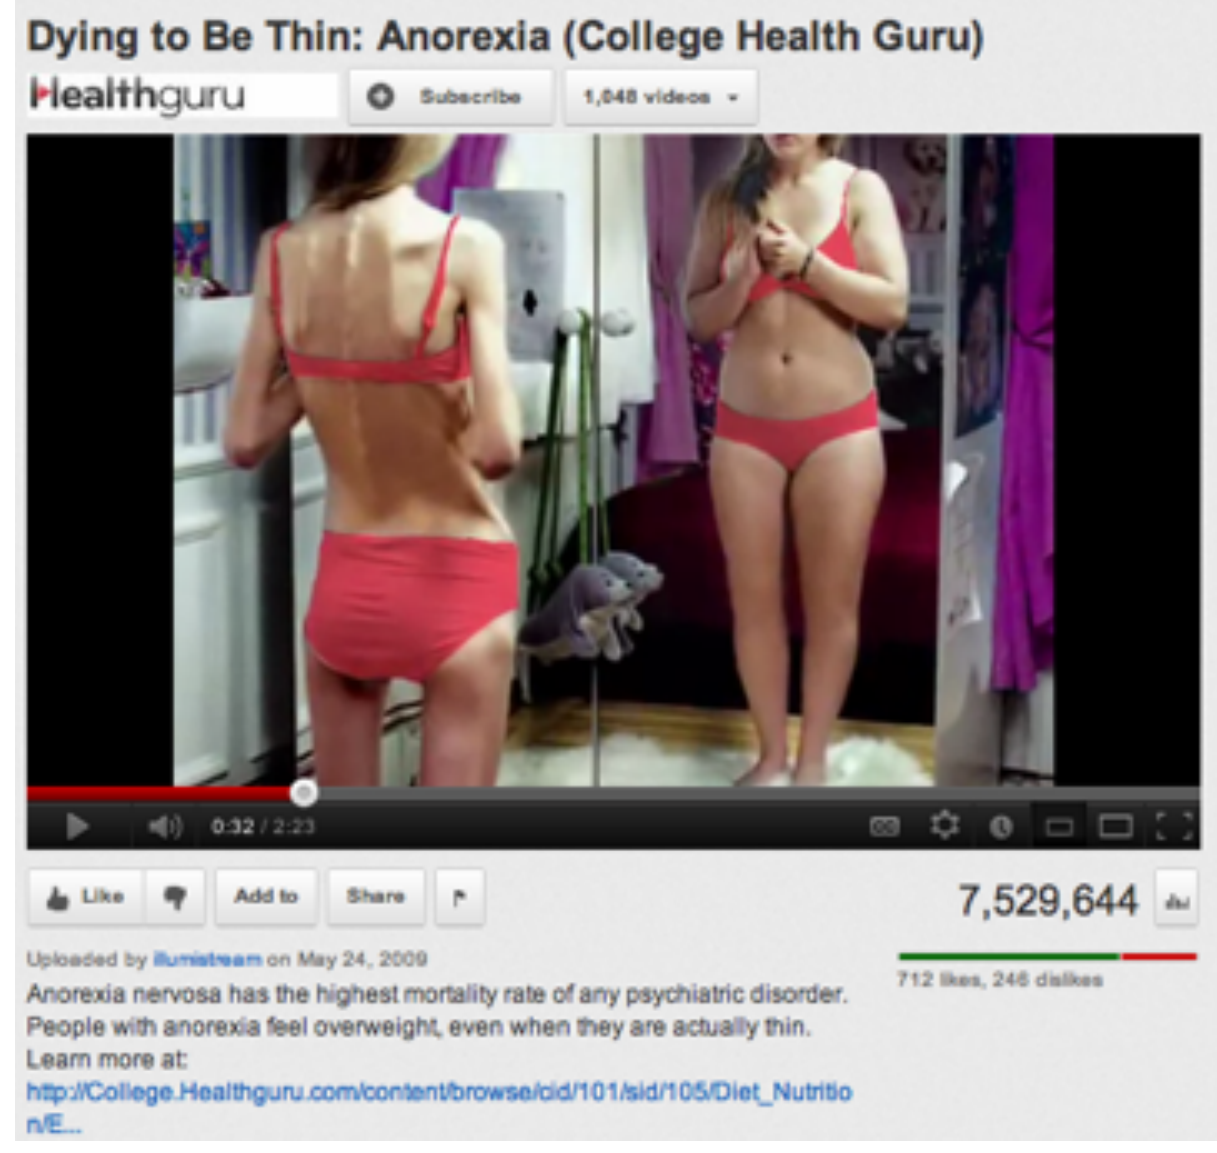
Figure 5. Screenshot of an informative video about anorexia.